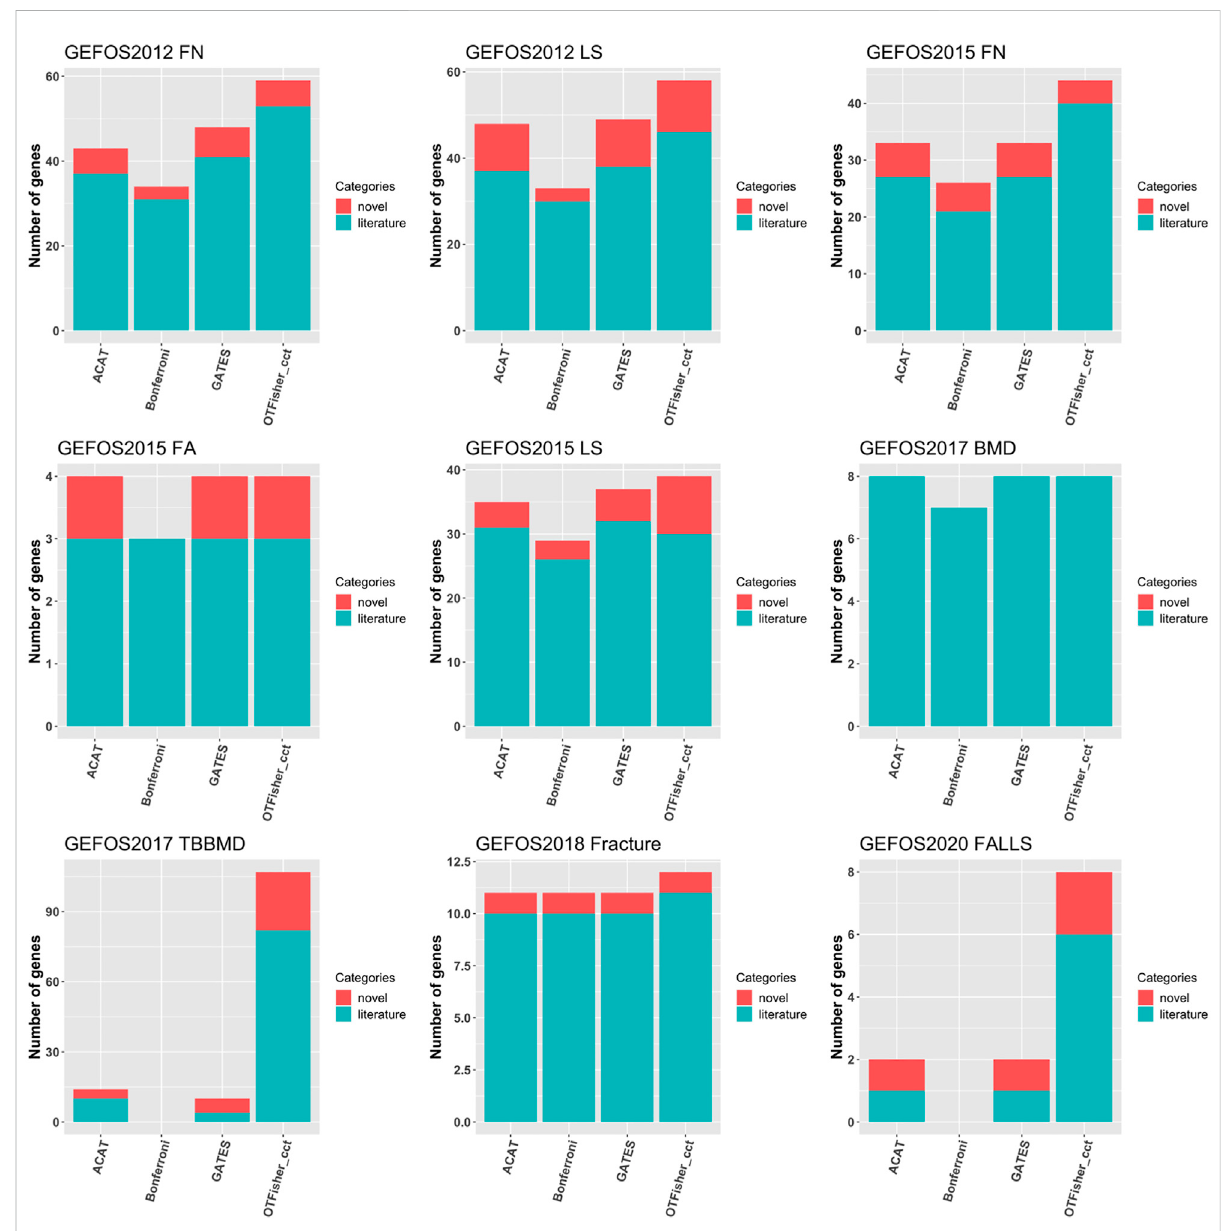
FIGURE 4 Bar chart for top-hit genes by various SNP-set analysis methods. Note: Bonferroni procedure corresponds to zero genes for GEFOS2017_TBBMD (because genome-wide signi fi cant SNPs were removed from the gene-based analysis of this data) and GEFOS2020_FALLS (because no genome-wide signi fi cant SNPs were mapped to